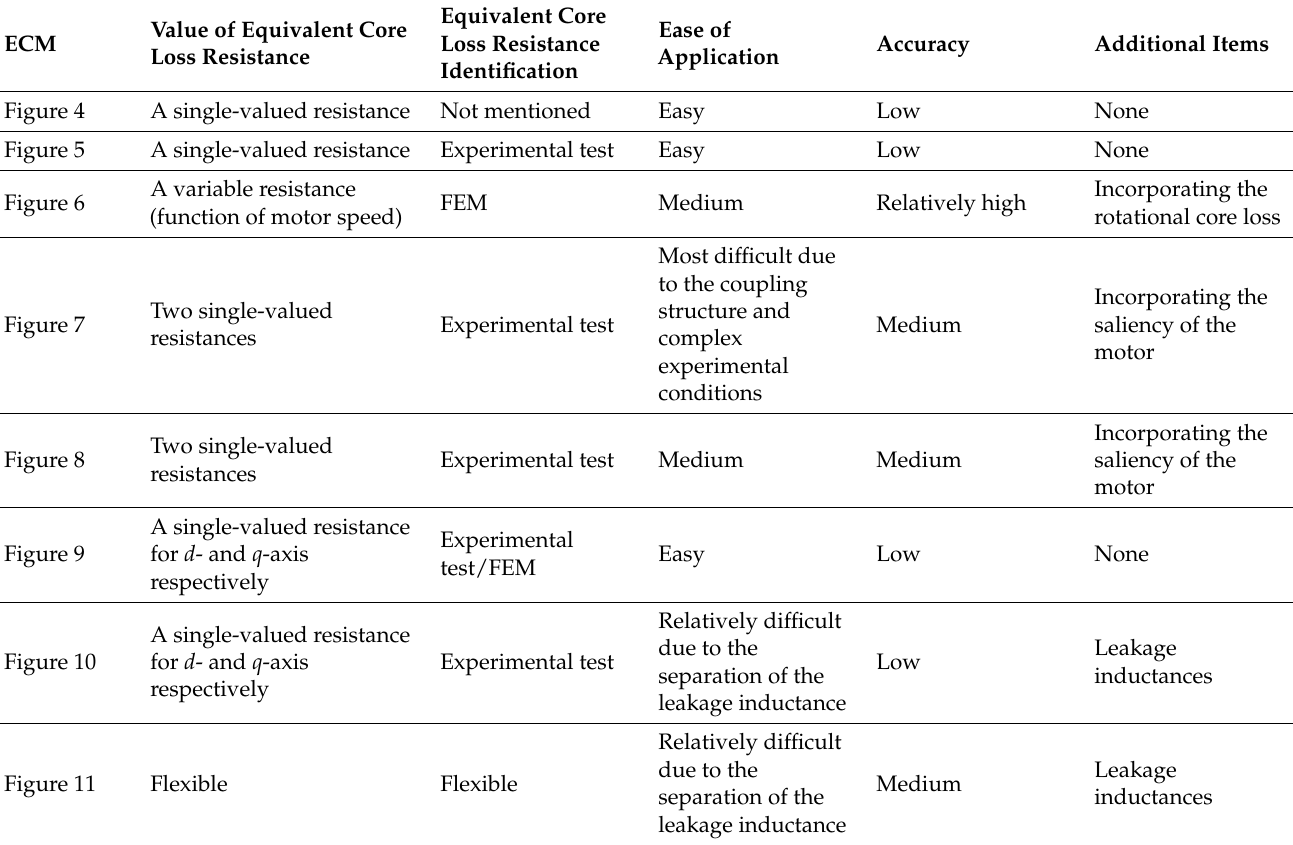
A single-valued resistance for d - and q